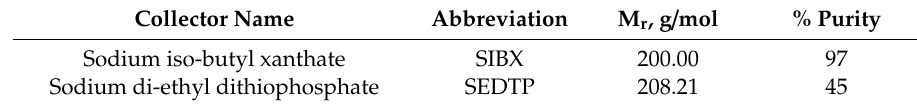
Table 3. Characteristics of the selected thiol collectors.